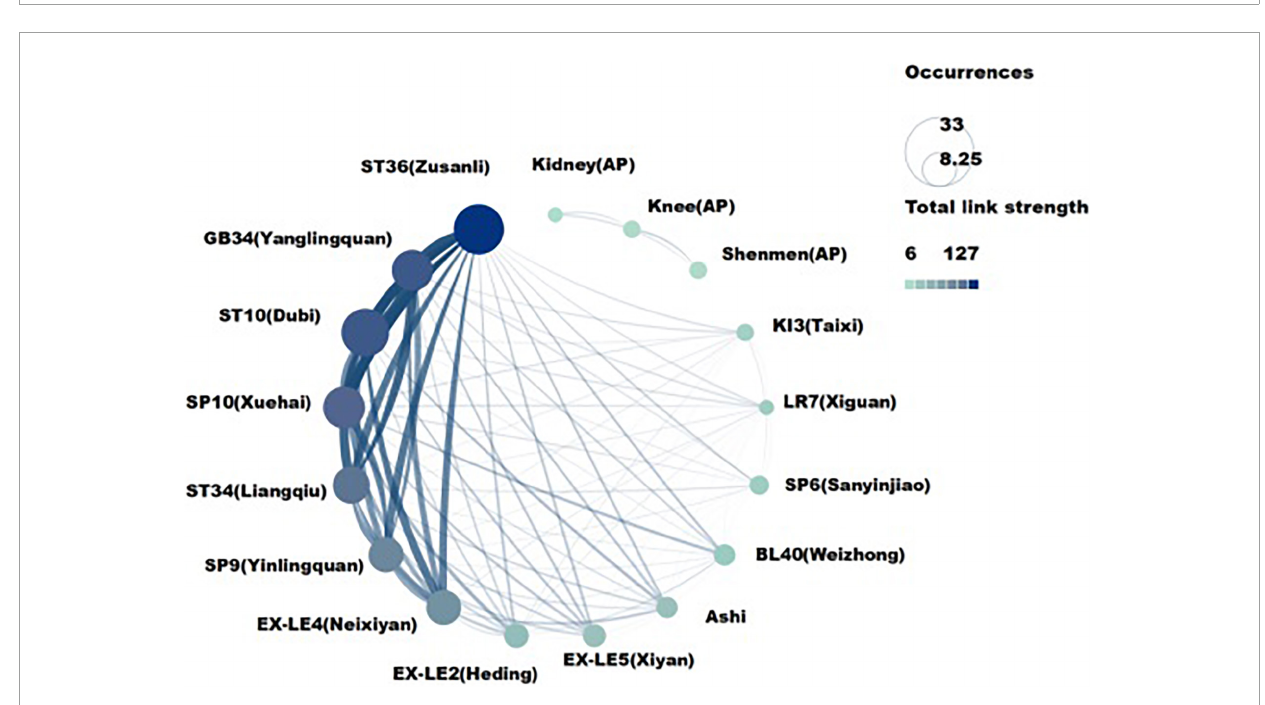
FIGURE10 The acupoints with co-occurrence frequency greater than five related to traditional Chinese non-pharmacological therapies on knee osteoarthritis